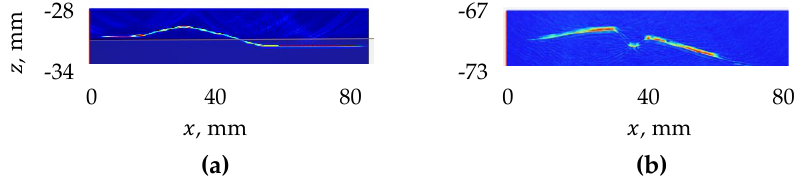
Figure 15. CEA experimental specimen. ( a ) The upper surface and ( b ) the backwall.